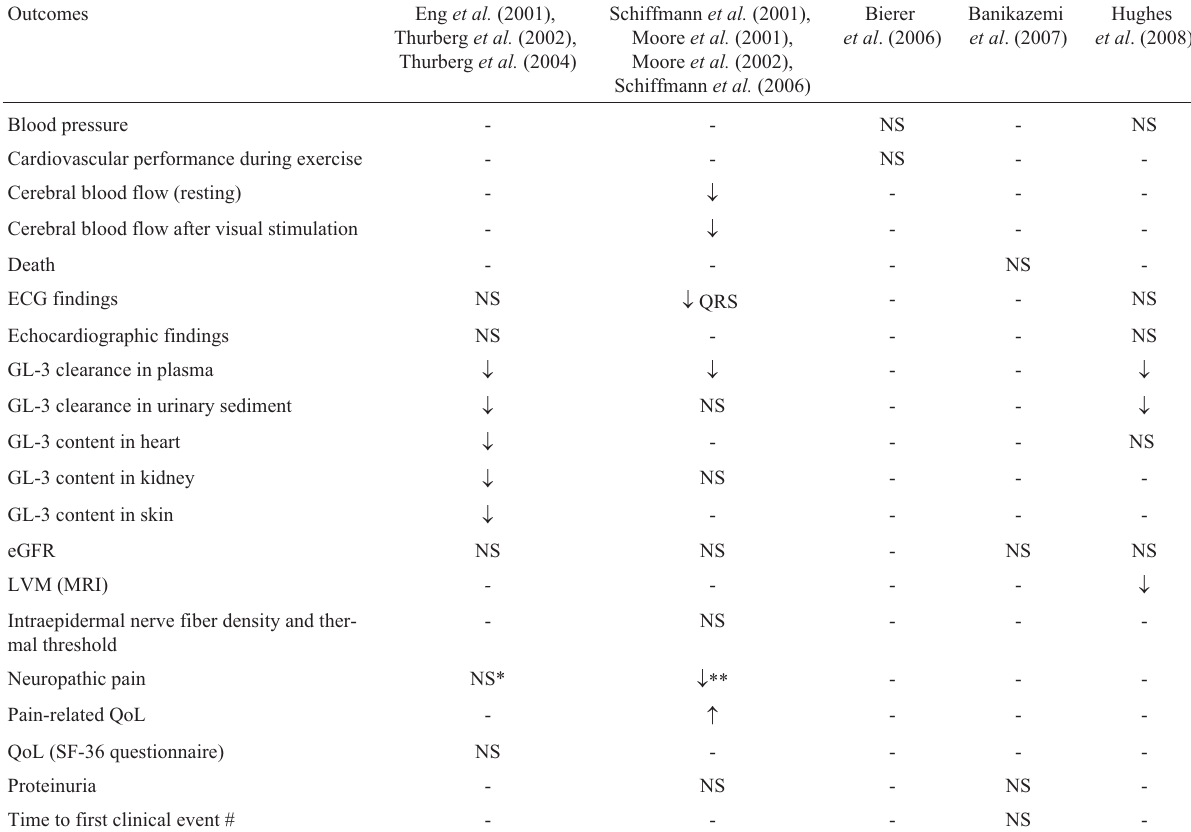
Table 2 - Summary of the efficacy results of enzyme replacement therapy with agalsidase for Fabry disease